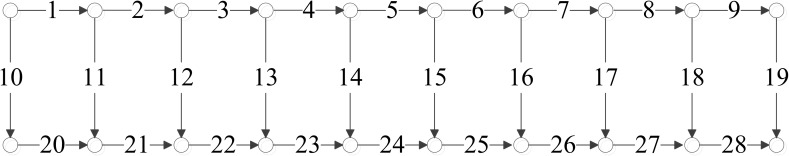
Transportation network 2.